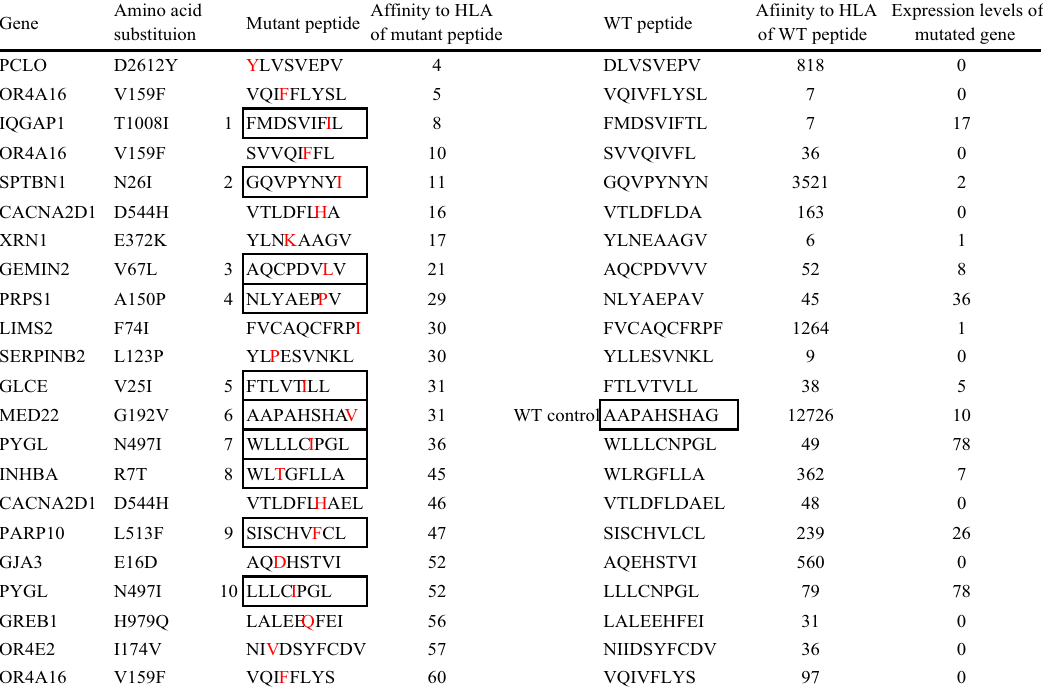
Table 3. List of predicted neoantigens with a high binding affinity for HLA-A02:06. The mutant peptides enclosed in squares indicate the candidates selected for peptide synthesis. The number on the left side of the candidate peptides refers to the synthesized peptides in the main text. WT: